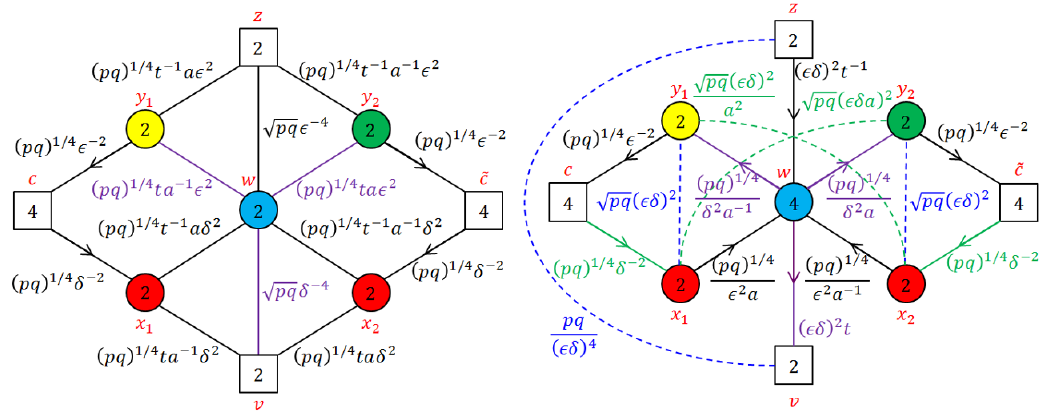
Figure 26 . Quivers of two E-string trinions S -glued together. On the right we have the initial two glued trinions. Using Seiberg duality on an SU(2) gauge symmetry we need to decide how to divide the (cid:12)elds to fundamental and anti-fundamental. We mark in black the (cid:12)elds we consider as fundamentals and in purple the ones considered anti-fundamentals of the SU(2) w gauge symmetry (Blue) on which we perform the duality. On the left, the resulting quiver after the duality. On this quiver we perform Seiberg duality on the two SU(2) x symmetries (Red). We mark in green the i (cid:12)elds considered anti-fundamentals and the rest are considered fundamentals.